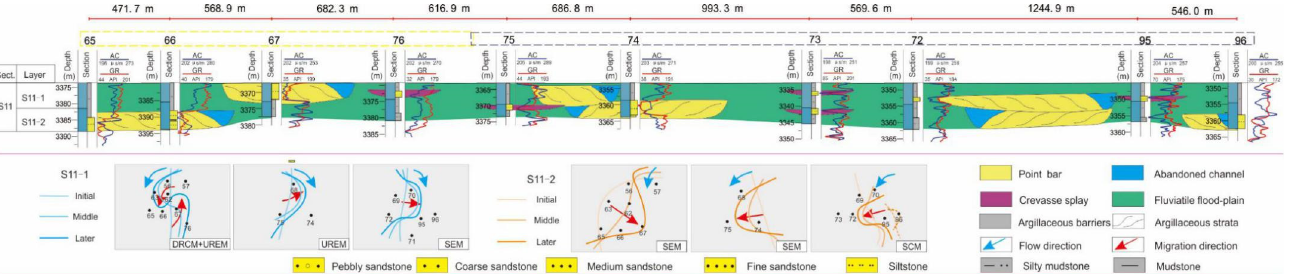
Figure 18. Profile T11 of comprehensive analysis including evolution model of meander bend-based multiple connected core wells which are collected from database in S 11 sublayer of Su-X block, Sulige gas field, Ordos Basin, China: migration areas Z3 (yellow frame), Z4(gray frame).